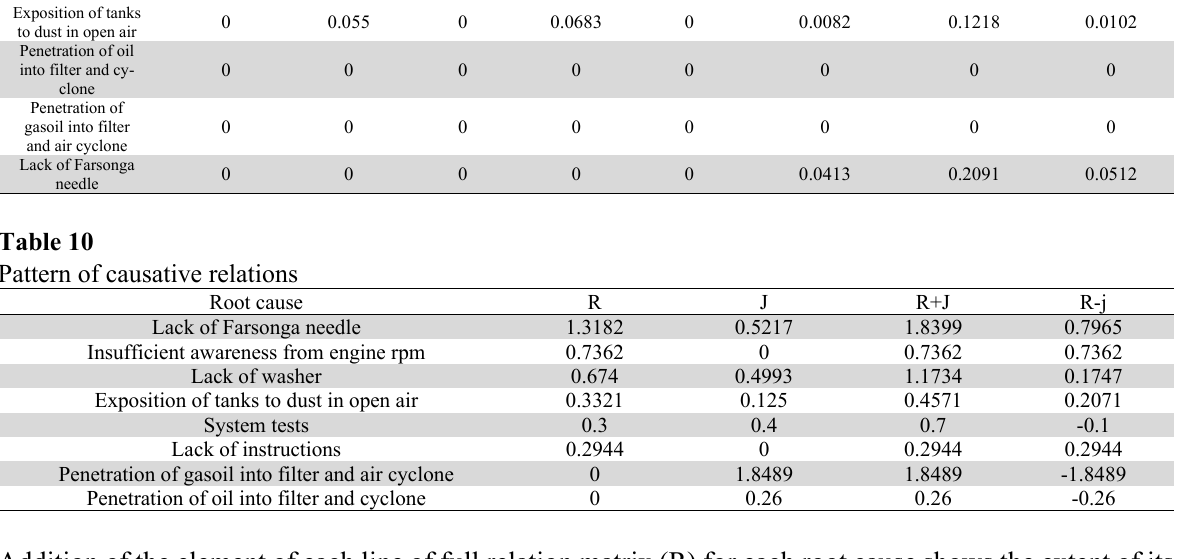
Penetration of oil into filter and cy-